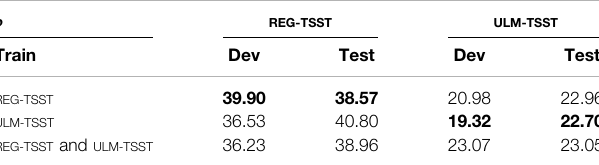
Emphasised results indicate strongest performance on given evaluation